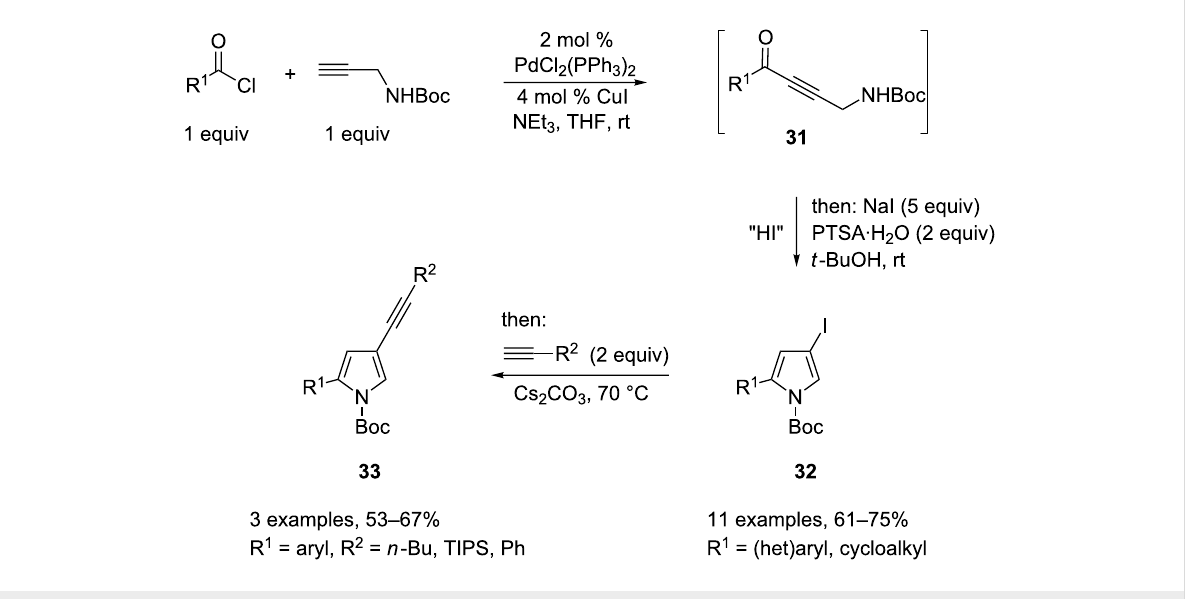
Scheme 17: Synthesis of pyrroles by cyclization of propargyl